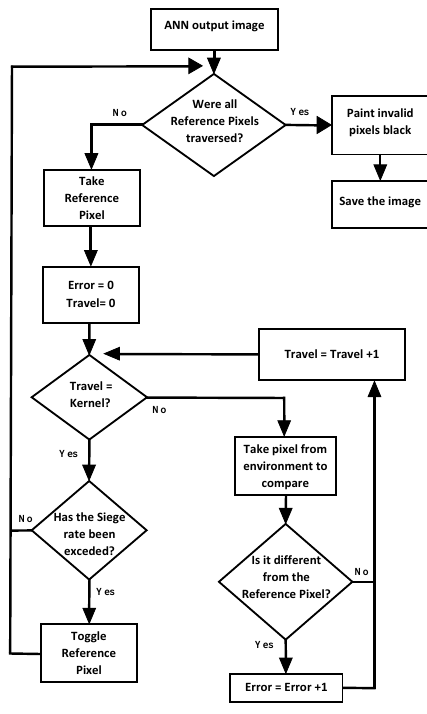
Figure 5. Verification